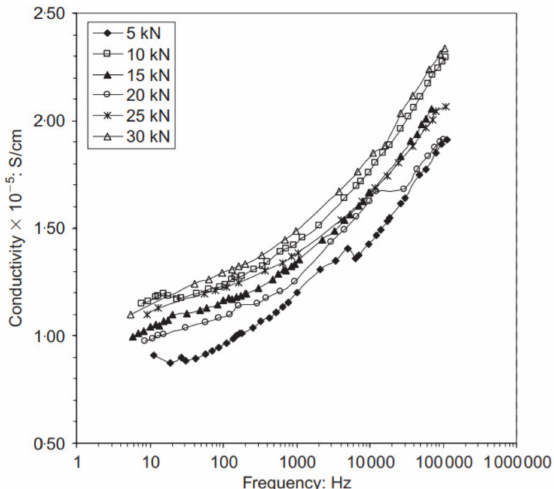
Figure 16. Change in conductivity versus frequency during loading process. Reproduced with permission from [71], Demirel et al.,